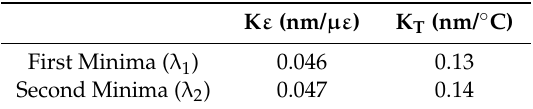
Figure 8. Wavelength shift of λ 1 and λ 2 as a function of temperature. Table 2. Sensitivity coefficient of D-shaped PMF loop mirror for both strain and temperature.